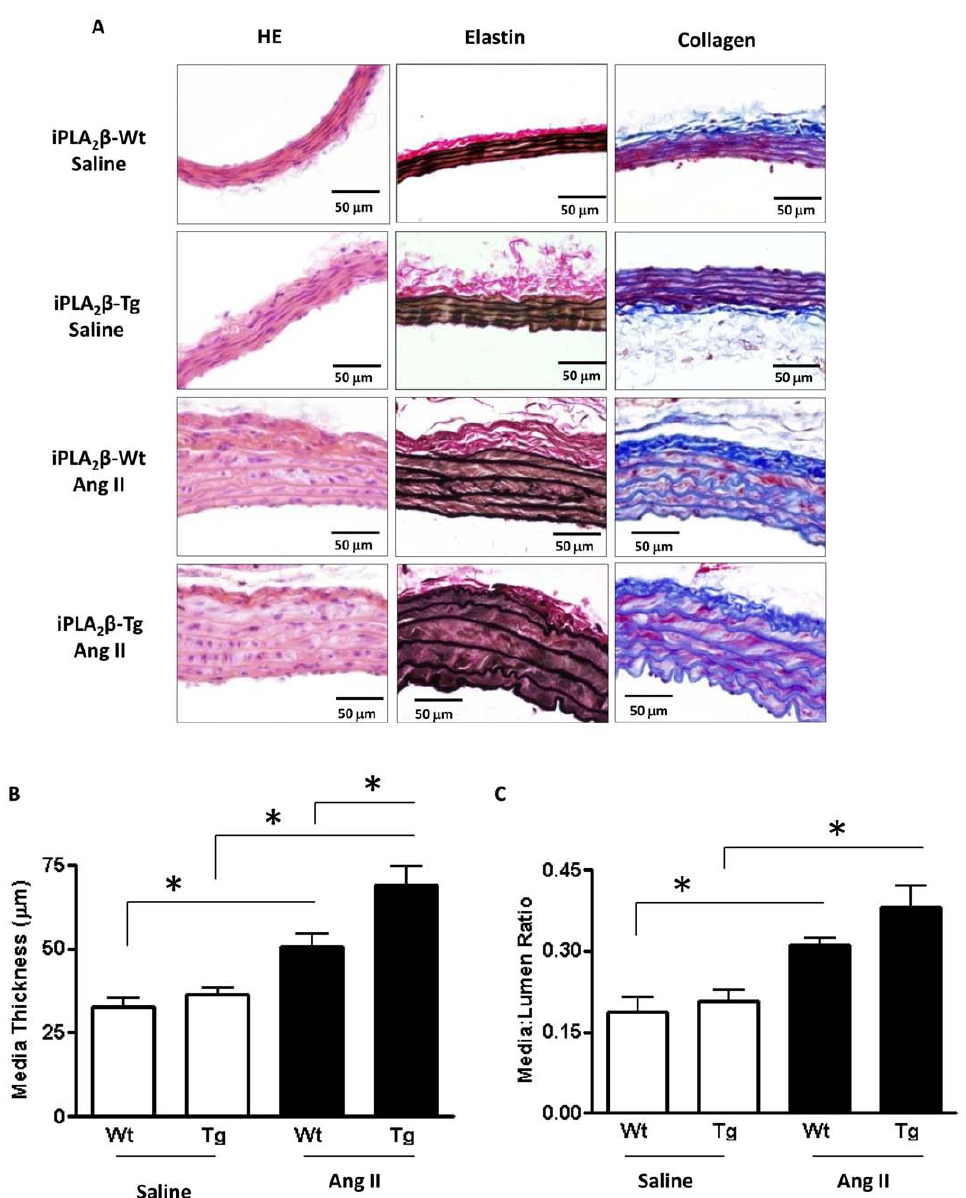
Figure 3. Exacerbated thoracic aorta remodeling in iPLA 2 b -Tg mice in response to Ang II infusion. Vascular remodeling was analyzed in the thoracic aorta of the iPLA 2 b -Wt and iPLA 2 b -Tg infused with Ang II (500 ng/kg/min) or saline. Representative images of vessel sections stained with HE, elastin or collagen ( A ). The media thickness ( B ) and media:lumen ratio ( C ) were quantified. n=8, **: p , 0.01, ***: p , 0.001 by one way ANOVA. doi:10.1371/journal.pone.0031850.g003 ration (Fig. 5C), verifying the essential role of iPLA 2 b and the 12/ 15 lipoxygenase pathway in Ang II-induced VSMC hypertrophy.